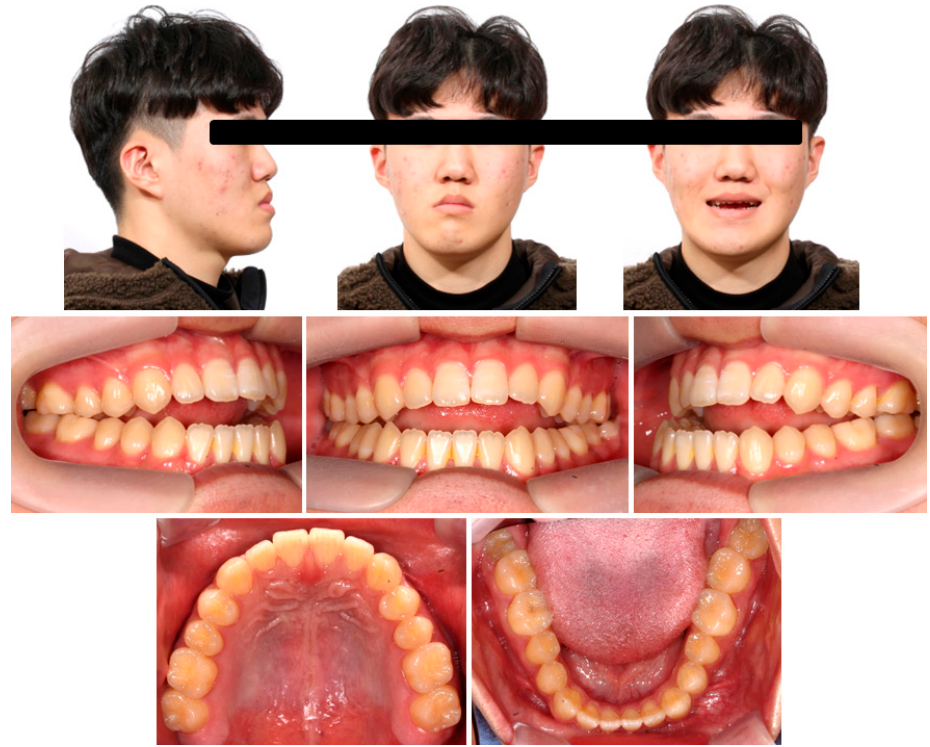
Figure 1. Pretreatment facial and intraoral photographs.